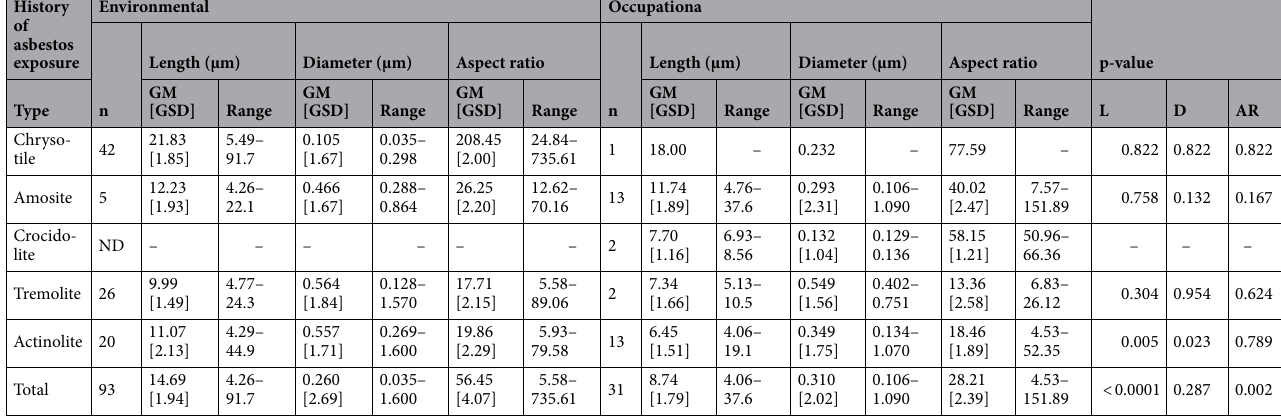
Table 7. Morphological characteristics (length, diameter, and aspect ratio) of the detected fibers by asbestos type. AR aspect ratio; D diameter; GM geometric mean concentrations; GSD geometric standard deviation; L length.